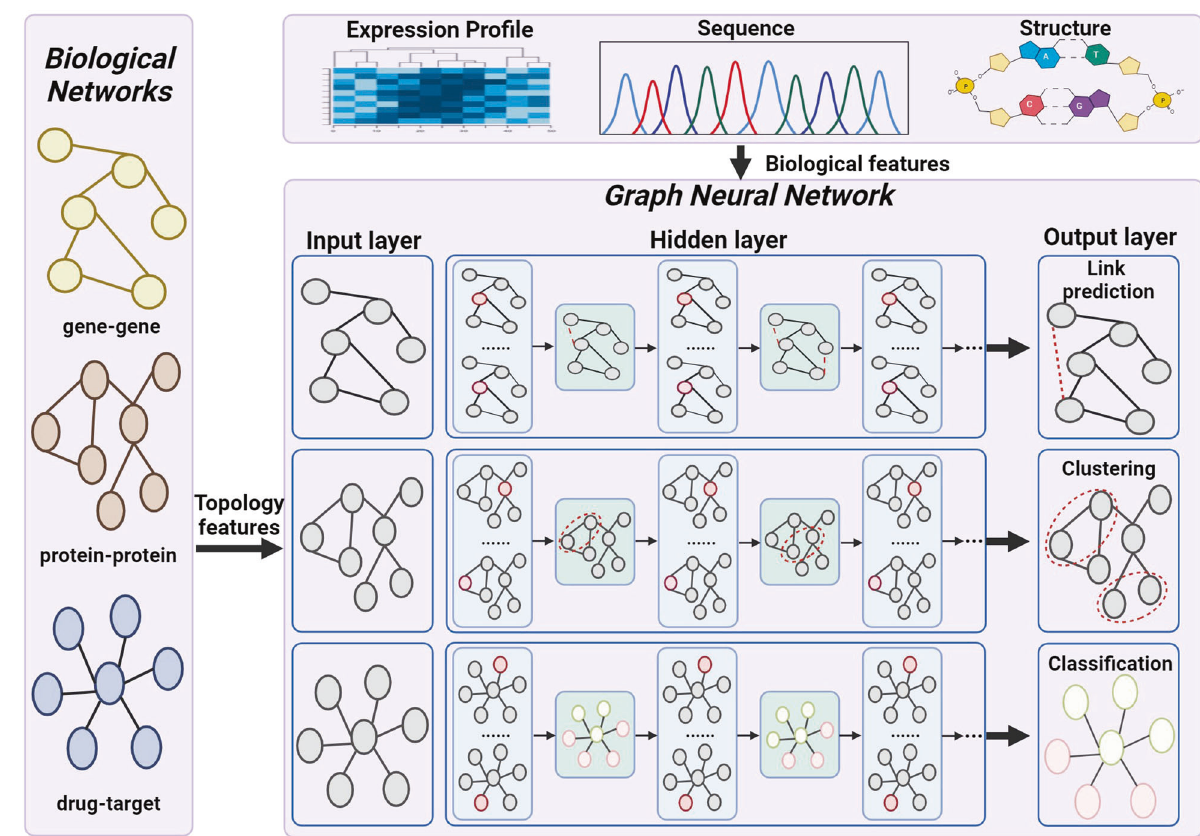
Fig. 8 The illustration of graph-based neural networks for ML-based biology analysis. The graph-based neural networks take the topology of the biological networks data (such as gene-gene networks, protein-protein networks and drug-target networks) as input data. And then, the graph-based neural network realizes the functions of link prediction, classi fi cation and clustering by analyzing the biological information in the network topology. (Created with